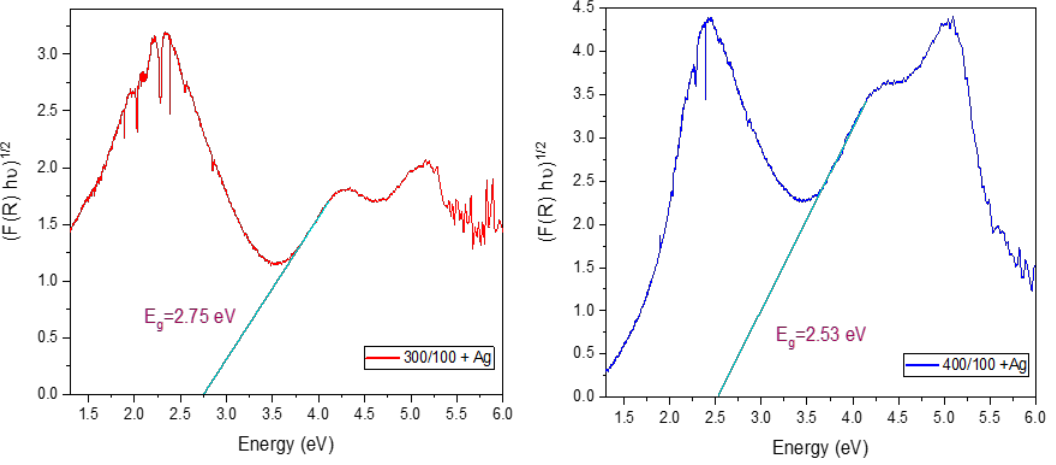
Figure 11. Tauc diagrams to calculate Eg of rings with TiO x catalytic coatings deposited using Ar-O 2 flow ratio 300/100 and 400/100.